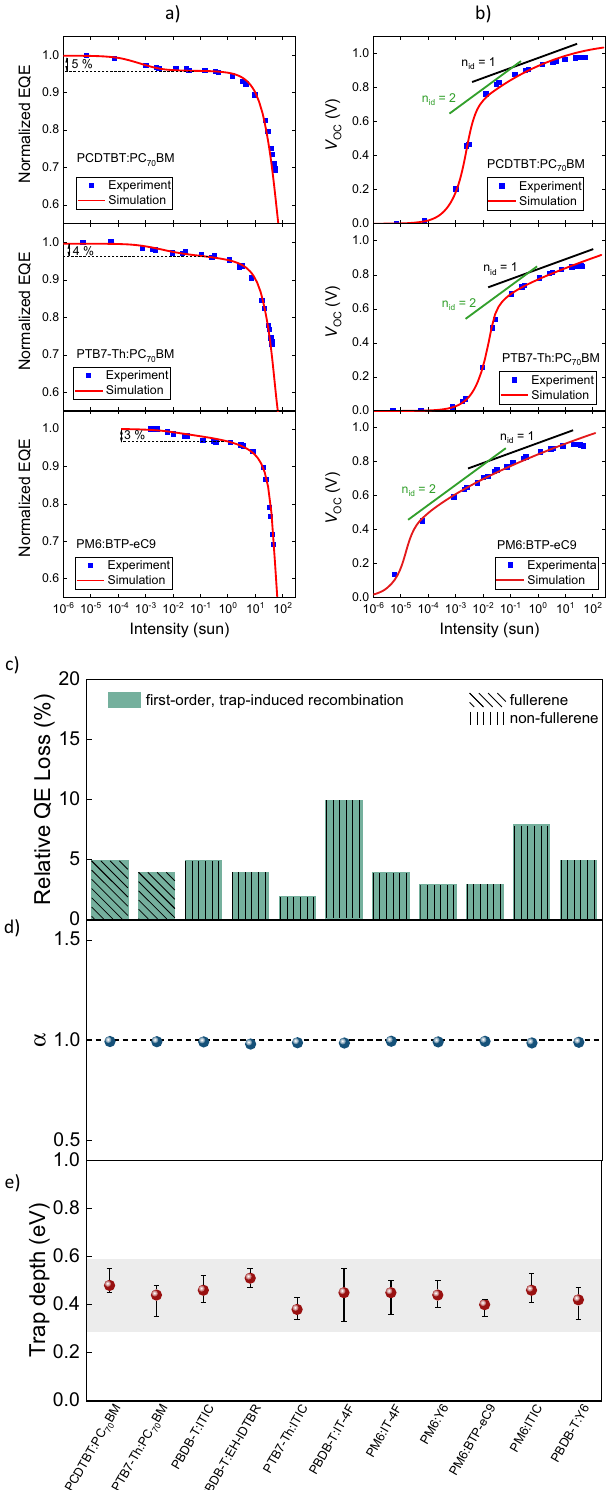
< Δ * ), is given by t t